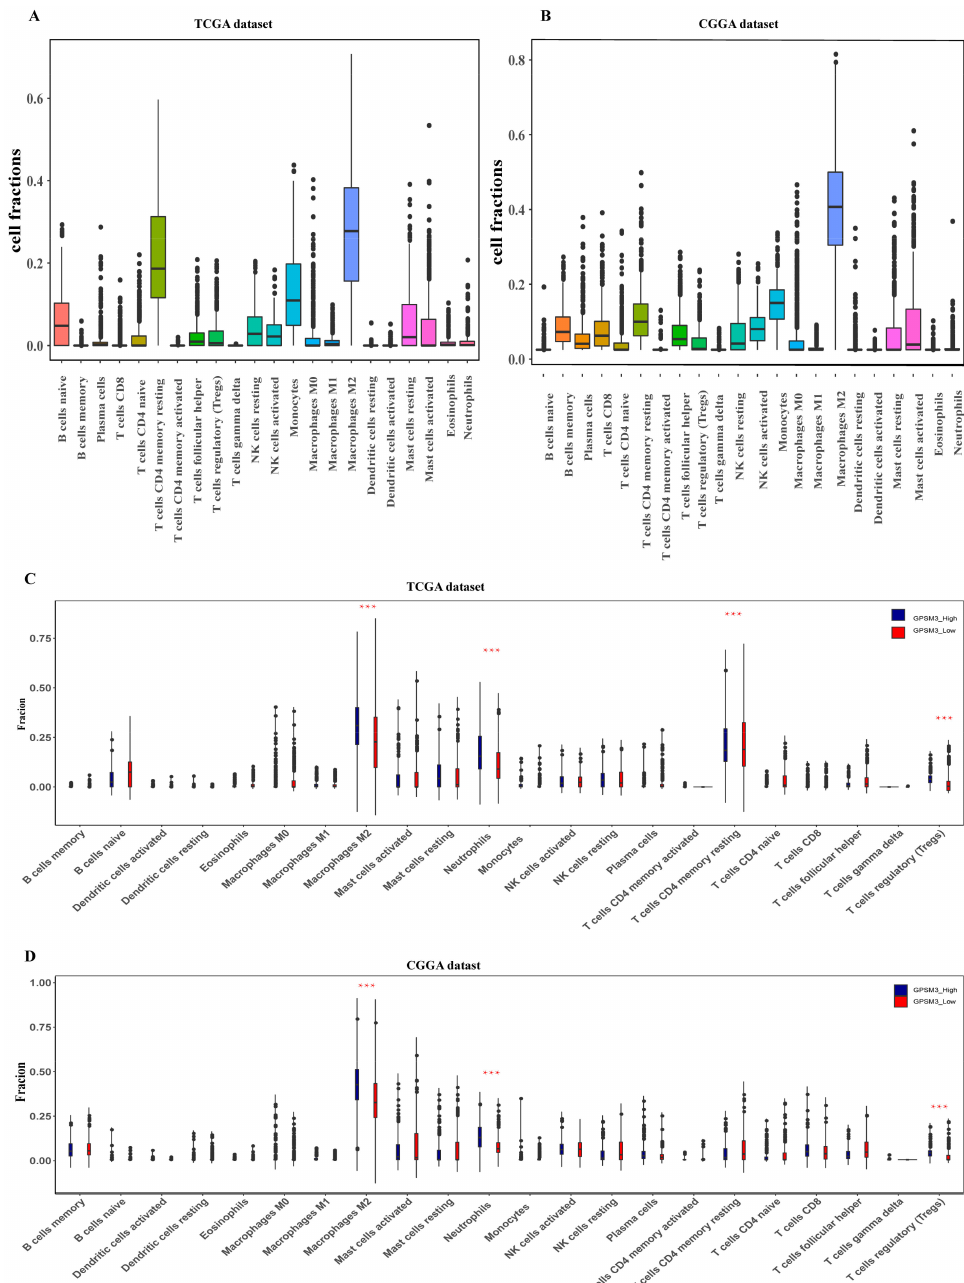
Figure 5. GPSM3-related immune population in the TME of LGG. ( A , B ) Bar plots showing the proportion of 22 immunocyte types in TCGA dataset and CGGA dataset. ( C , D ) Violin plots showing the differences in the proportion of 22 immunocyte types between GPSM3 high and low expression groups. Blue colors represented the group with GPSM3 high expression; Red color represented the group with GPSM3 low expression. The symbol *** indicated p <